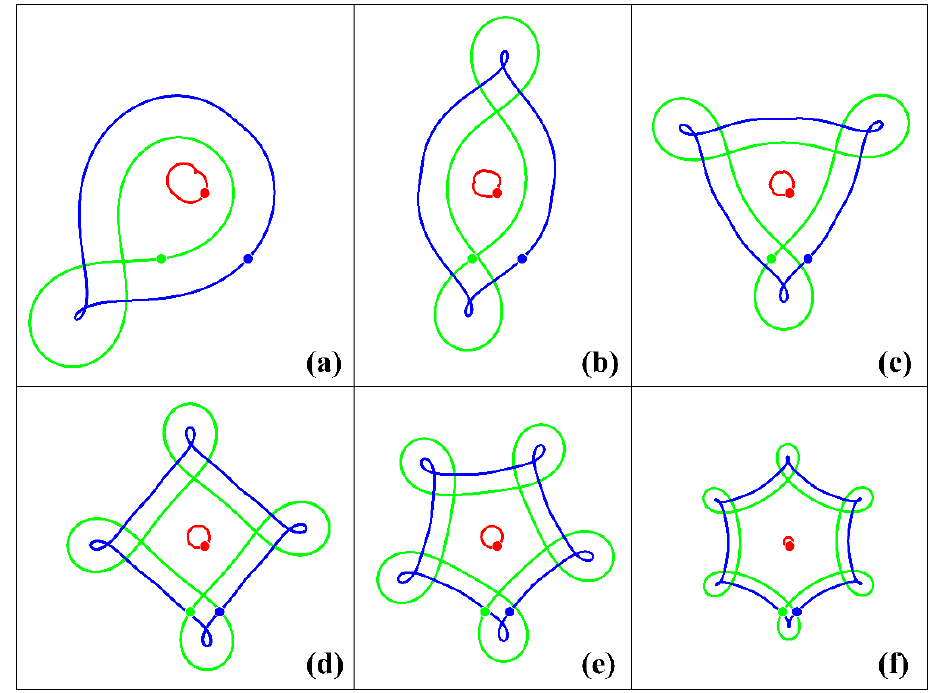
= 1/4; Λ 1 = − 1/2; and / Λ 1 / Λ 2 2 2 2 1